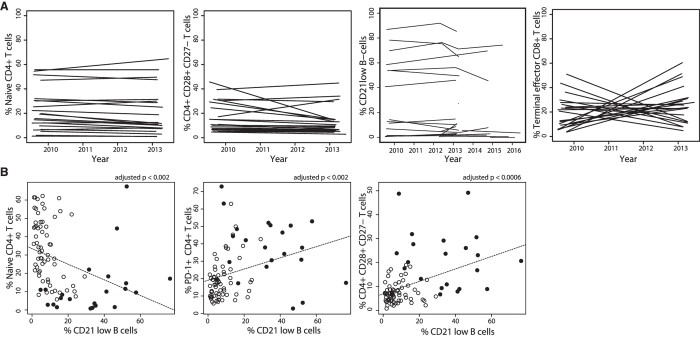
Stability and relationships of defining lymphocyte populations.CVID-AcT patients’ samples contain the same proportion of the defining populations (naïve, intermediate CD28+CD27− CD4+ T-cells, CD21lo B-cells) when measured more than 3 years apart, which is in contrast to the dynamic compartment of terminal effector CD8+ T-cells. The line connecting the two time points is shown to visualize the trends (A). Investigation of the mutual relationship of the relevant populations shows orchestrated changes in the patients’ immunophenotypes (B).